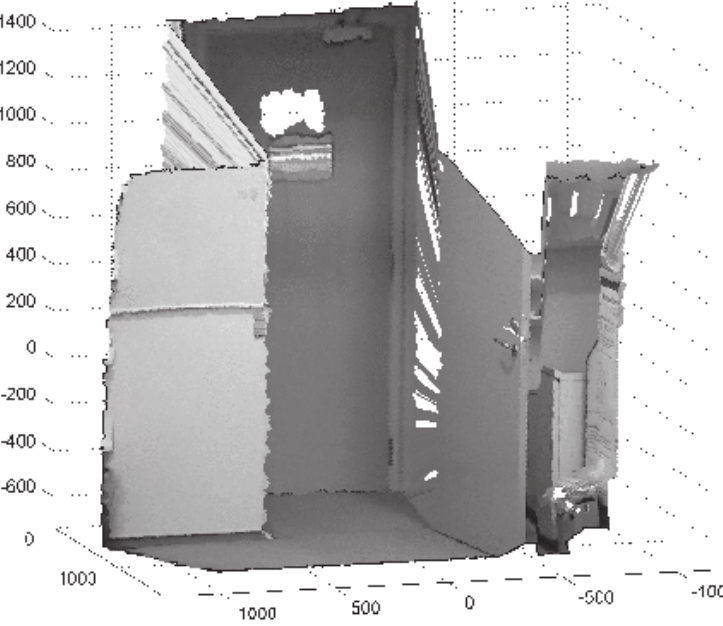
sensor. The units are represented in mm TM